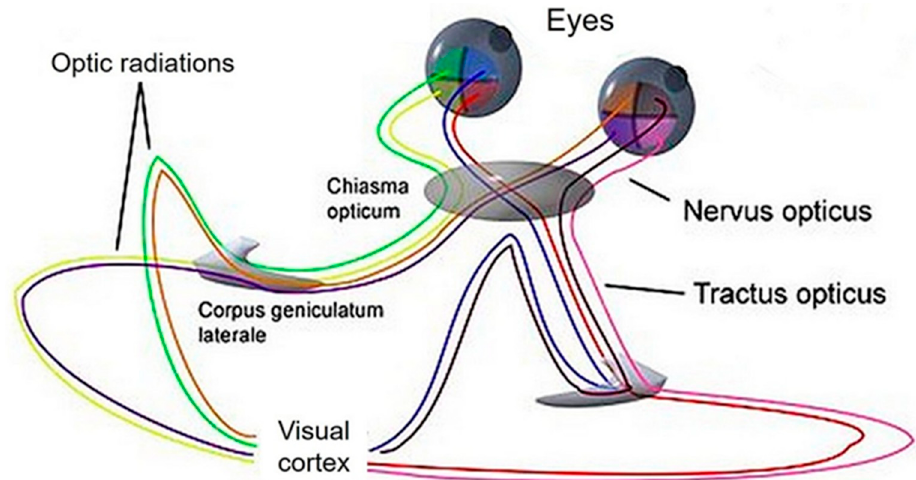
Figure 1. Visual pathway. The visual pathway starts when light passes through the cornea and lens to reach the retina, and continues through the optic nerve, optic chiasm, optic tract, lateral geniculate body and optic radiation until it reaches the primary visual cortex. https://de.wikipedia.org/wiki/Sehbahn (accessed on 5 April 2023).